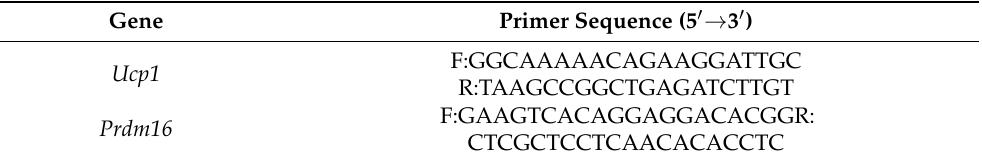
Table 1. Primer sequences used for qRT-PCR.